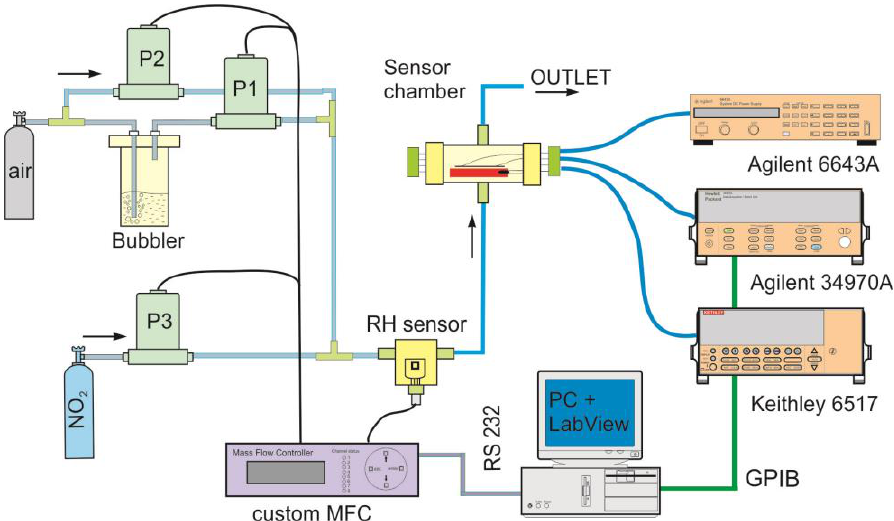
Figure 4. Illustration of a measurement setup used for determination of the gas sensing characteristics of the investigated structures.